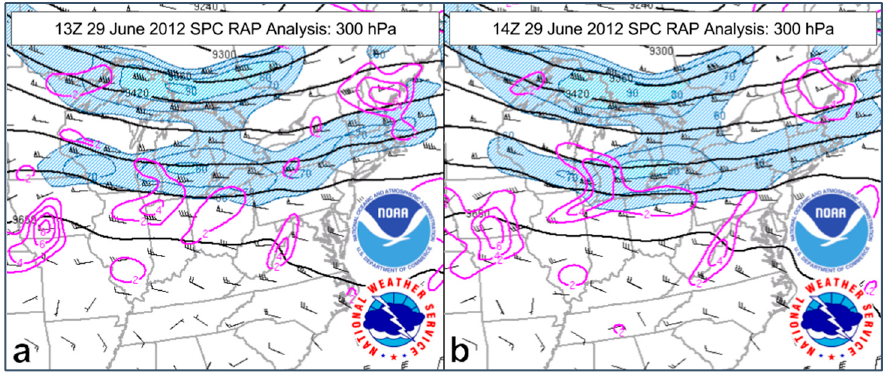
Figure 8. 300 hPa SPC experimental RAP analyses of isoheights (black in m), isotachs (blue fill in kts), and divergence (solid cyan in 10 − 5 s − 1 ) for ( a ) 13Z 29 June and ( b ) 14Z 29 June 2012.